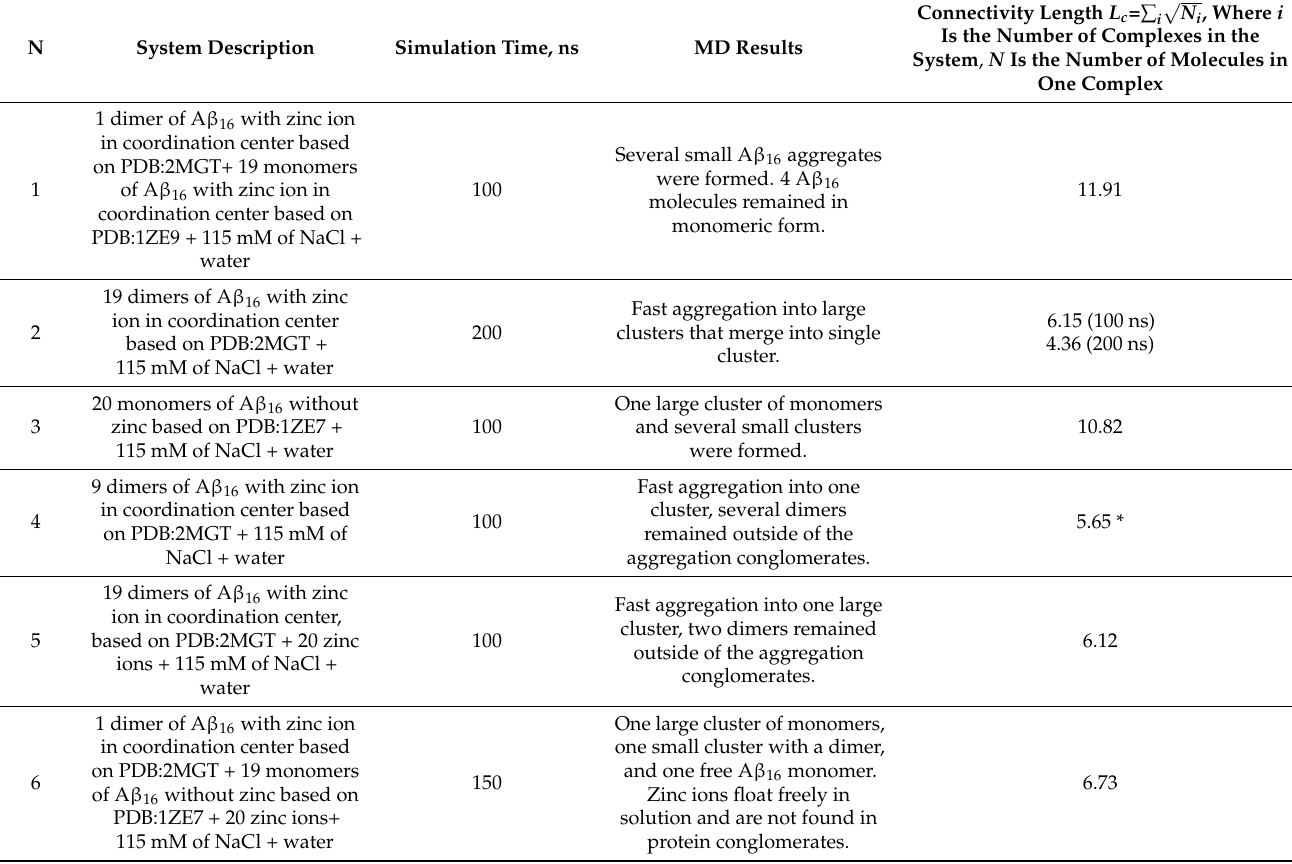
One large cluster of monomers 100 and several small clusters were